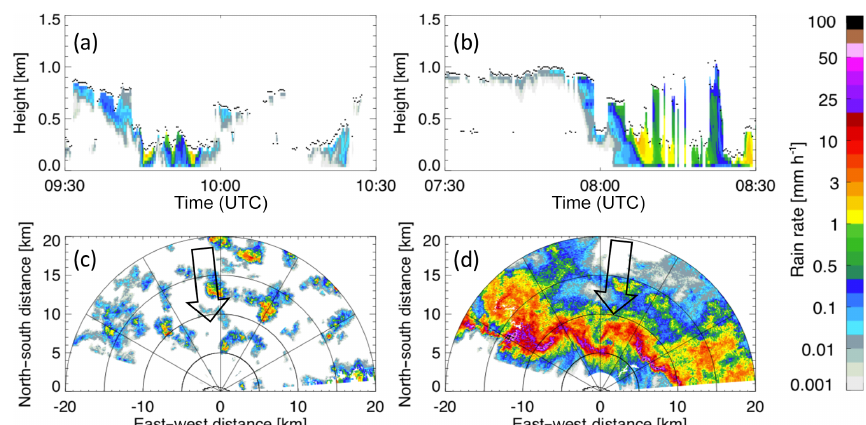
Figure 5. Retrieval of popcorn convection precipitation rate on 2 February 2018 using (a) KAZR2 (zenith between 09:30 to 10:30UTC) and (c) KaSACR2 (1 ◦ elevation PPI at 10:00UTC). Retrieval of squall line precipitation rate on 2 March 2018 using (b) KAZR2 (zenith between 07:30 to 08:30UTC) and (d) KaSACR2 (1 ◦ elevation PPI at 08:00UTC). Also indicated are the location of cloud bases (black dots in panels a – b ) and the general wind direction (arrows in panels c – d ). Note that KAZR2 is located at 0km north–south and